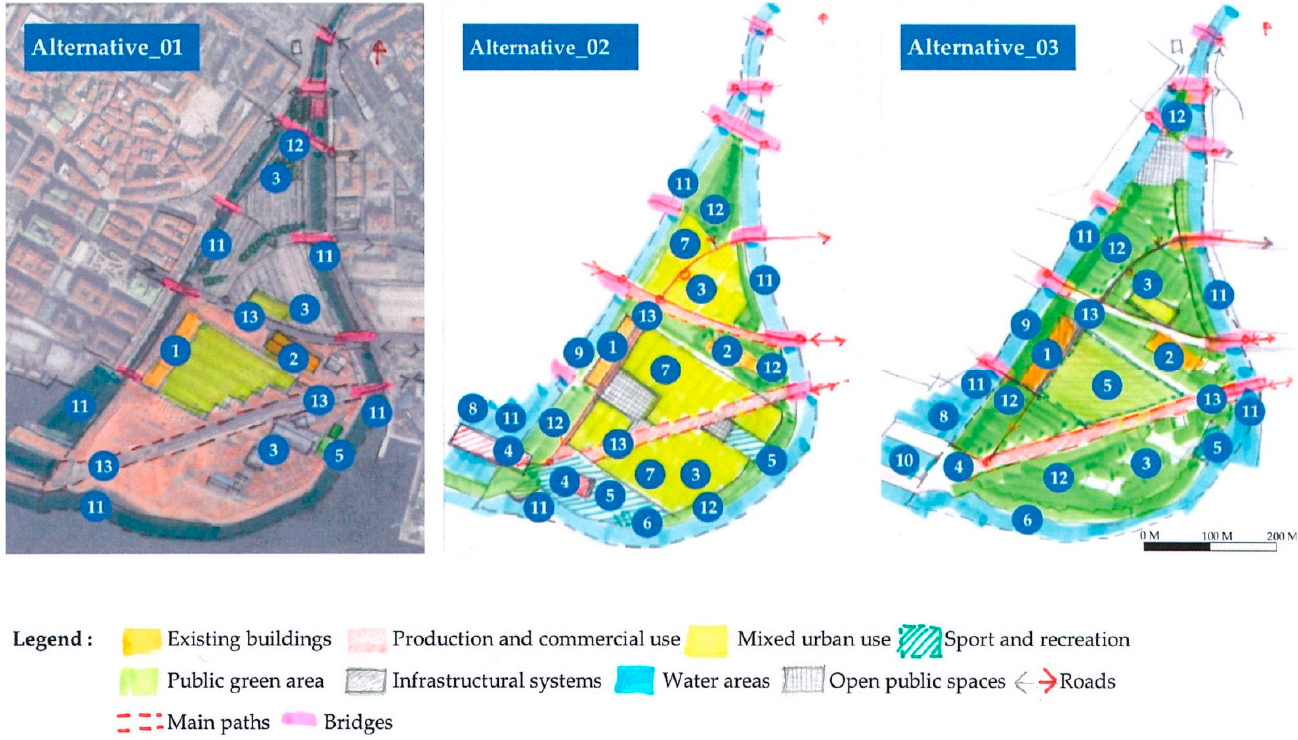
Figure 5. Alternative scenarios: 1—public use, 2—business area, 3—communal services, 4—business, commercial and tourism, 5—sport and recreation, 6—sport and recreation—swimming area, 7—mixed use, 8—nautical tourism port, 9—sports port, 10—fishing port, 11—water areas, 12—green areas, 13—infrastructure.